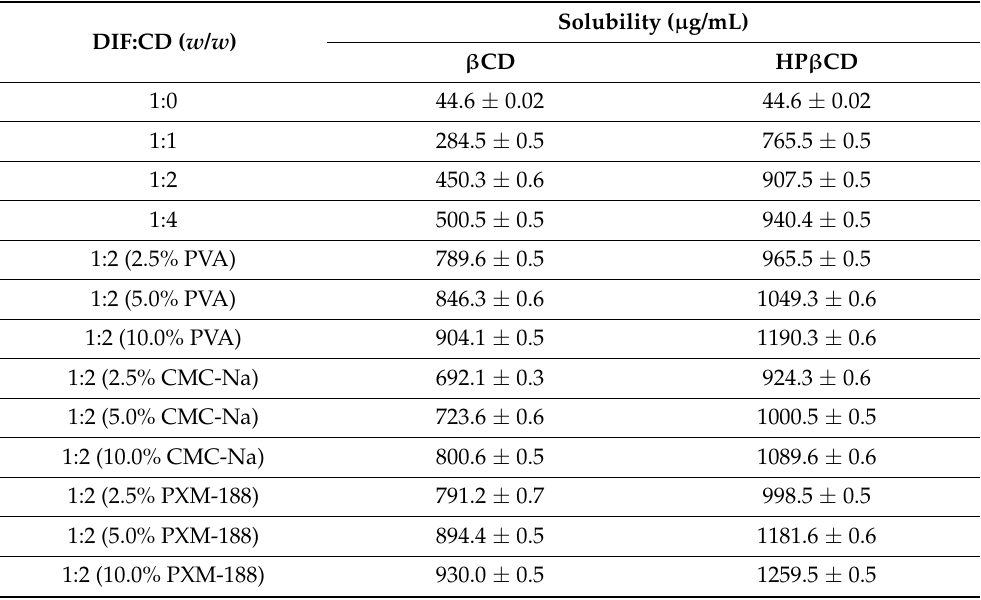
Table 1. Solubility data of diflunisal and various cyclodextrin inclusion complexes. Reproduced from [46], with permission from MDPI, 2021.